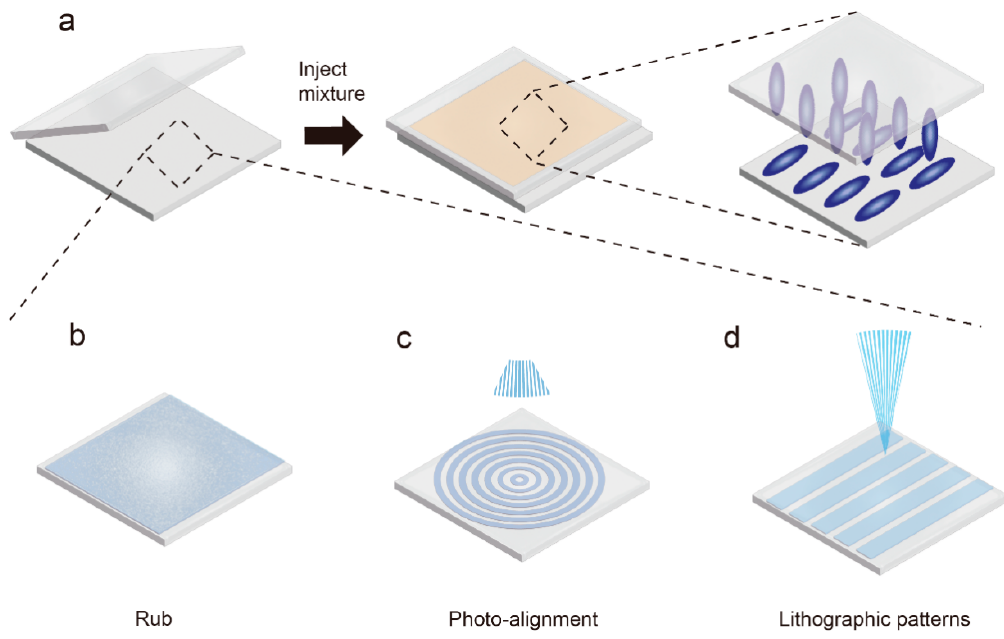
Figure 7. Schematic diagram of making an oriented substrate and surface-induced orientation of LCE. ( a ) Liquid crystal molecules aligned by layer; ( b ) fabrication of oriented substrates by friction; ( c ) production of oriented substrates by photosensitive materials and light sources with pattern information; ( d ) microchannels are formed on the substrate surface by